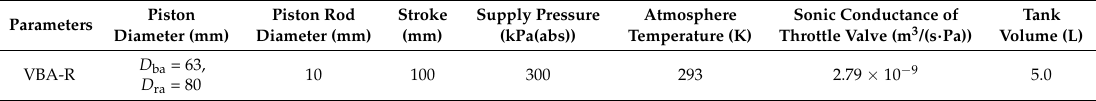
Table 2. Parameters and values used in the